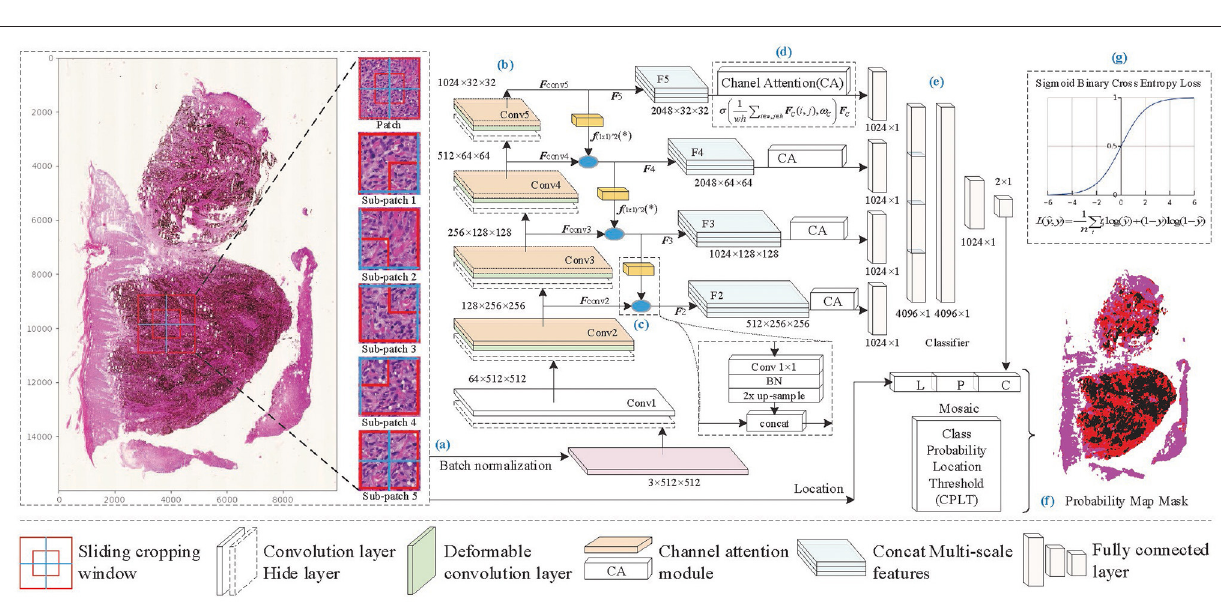
FIGURE 2 | The framework of the proposed method. (A) Patch processing, (B) feature extraction, (C) feature fusion, (D) feature selection, (E) predictive classification, (F) probability map generation, and (G) loss function of training